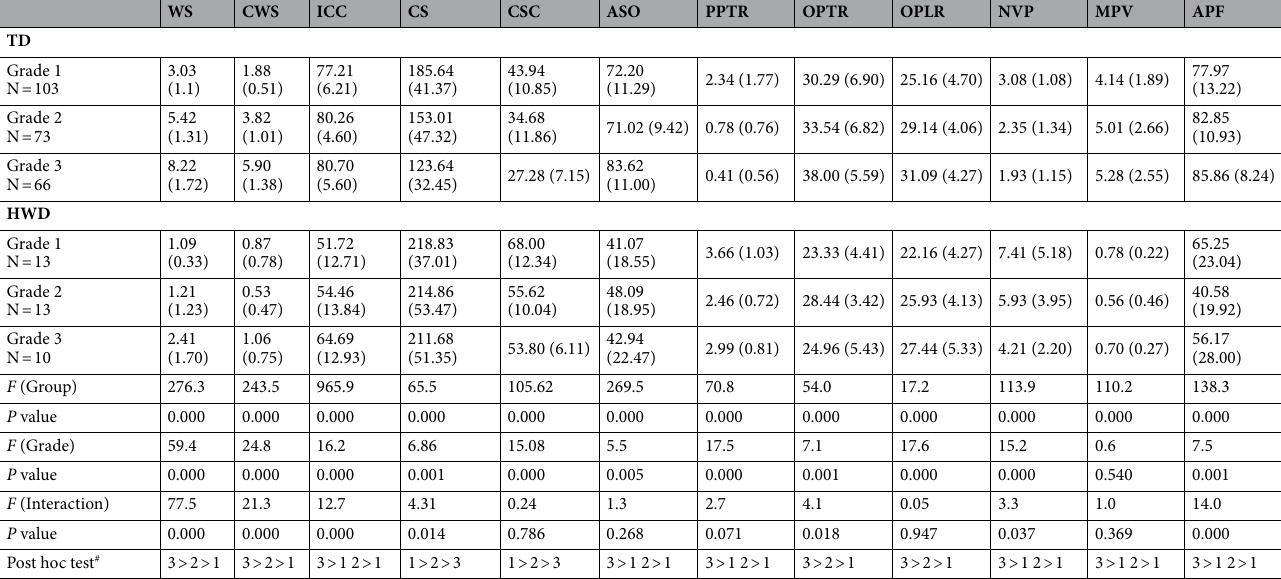
Table 5. The comparison of testing measures among three grades and two groups. TD Typical development, HWD Handwriting deficit, WS Writing speed, CWS Correct writing speed, ICC Intra-character configuration, CS Character size, CSC Character size consistency, ASO Accuracy of stroke order, PPTR Pen pause time ratio, OPTR On-paper time ratio, OPLR On-paper length ratio, NVP Number of velocity peak per stroke, MPV Mean peak velocity, APF Axial pen force. # The post hoc test shows the comparisons between grades in the TD group.